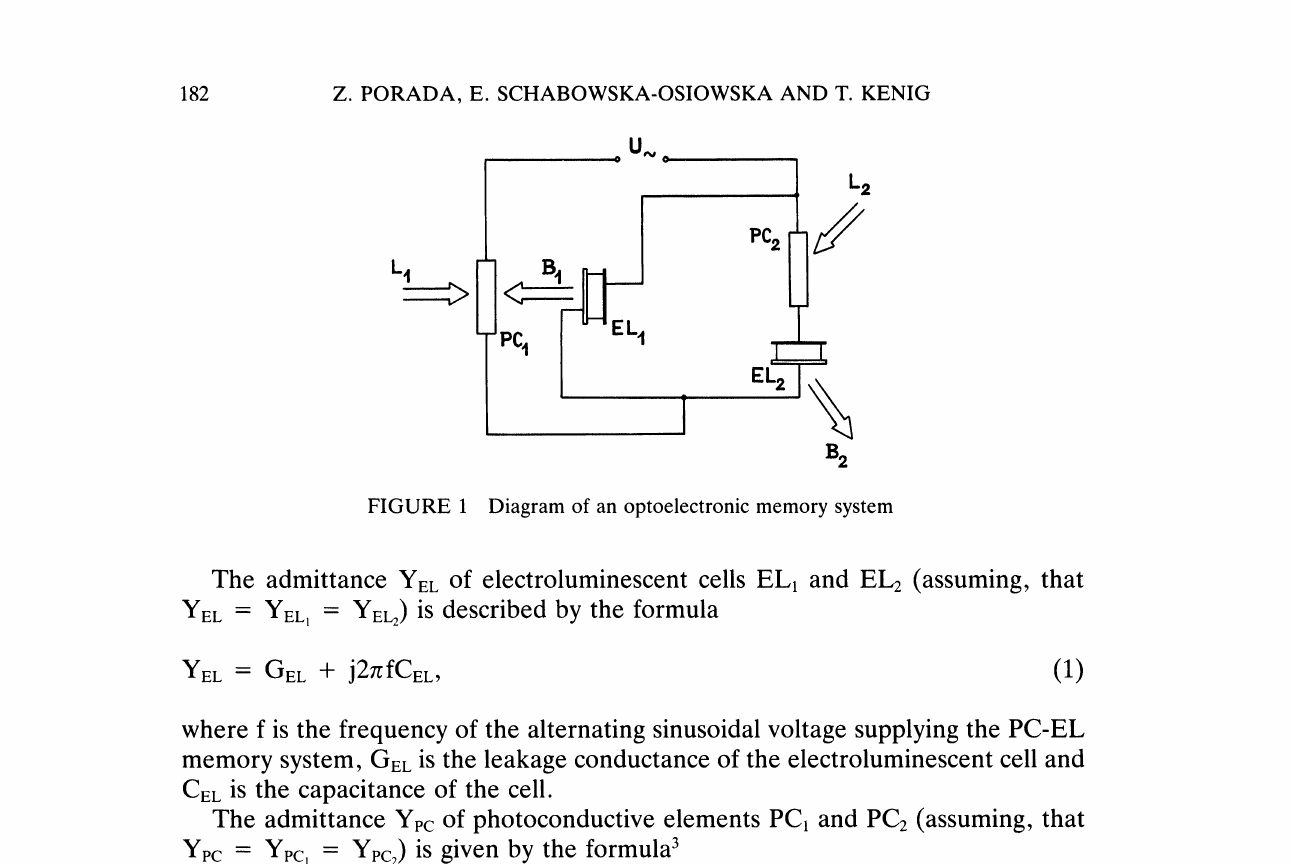
FIGURE Diagram of an optoelectronic memory system